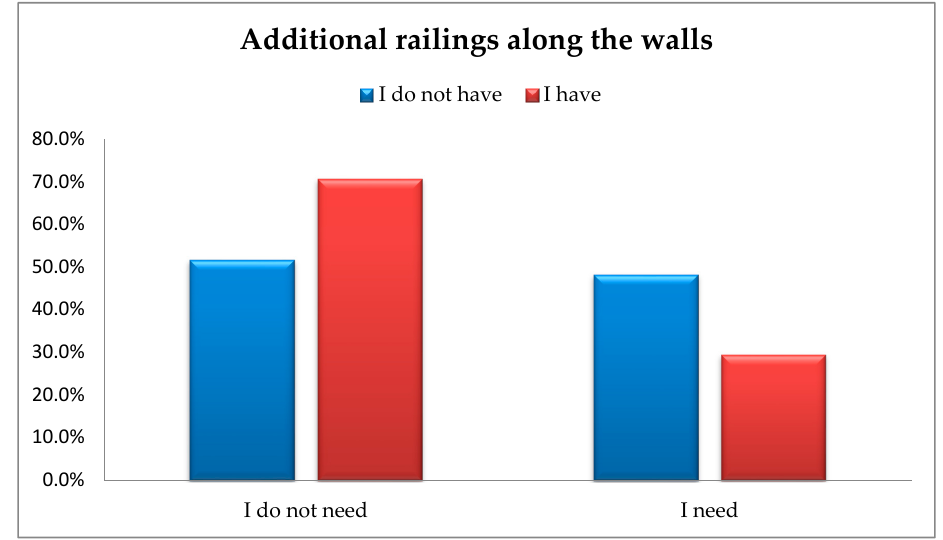
Figure 4. The availability of additional railing along the walls vs. actual respondents’ demand for this type of facility.